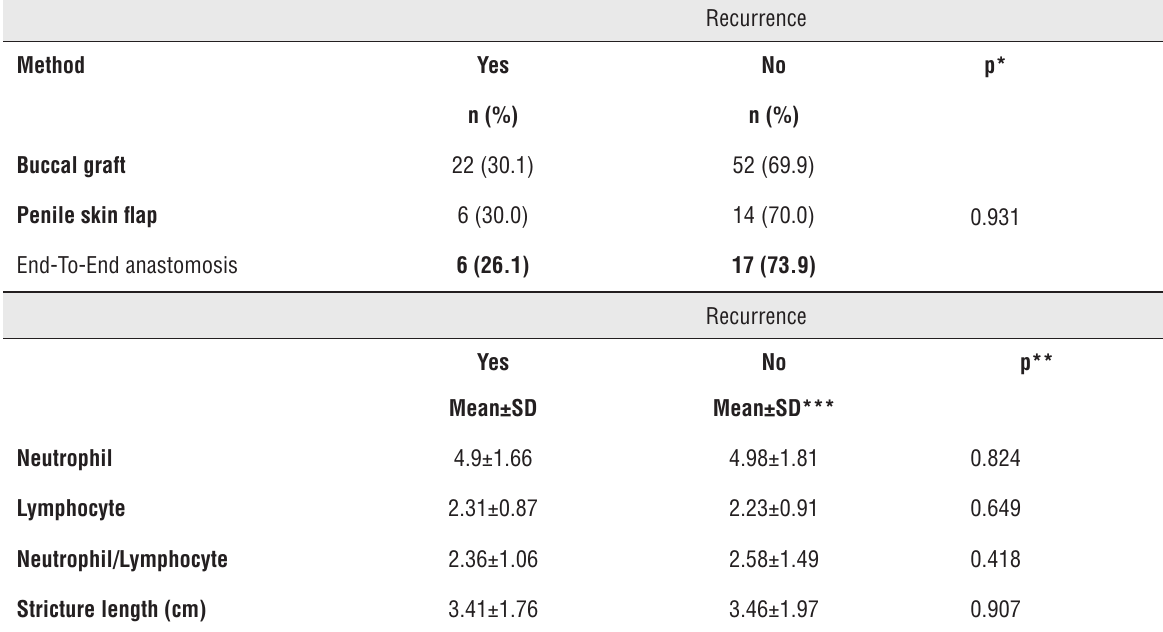
Table 2 - Recurrence evaluation according to surgical method and blood